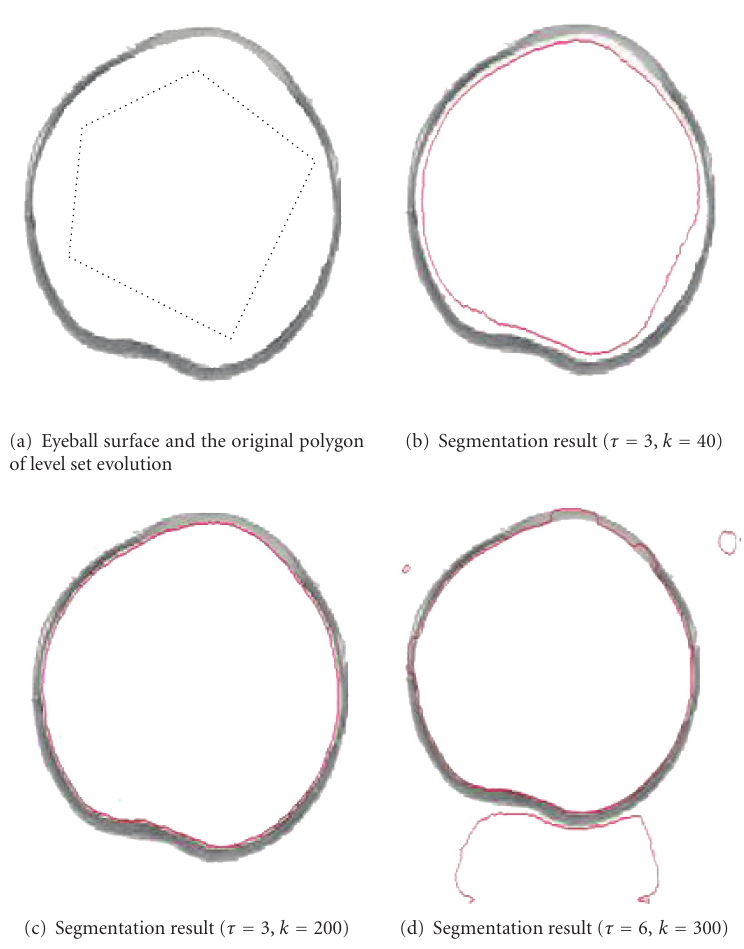
Figure 5: Extracting the inner surface of an eyeball through a level set